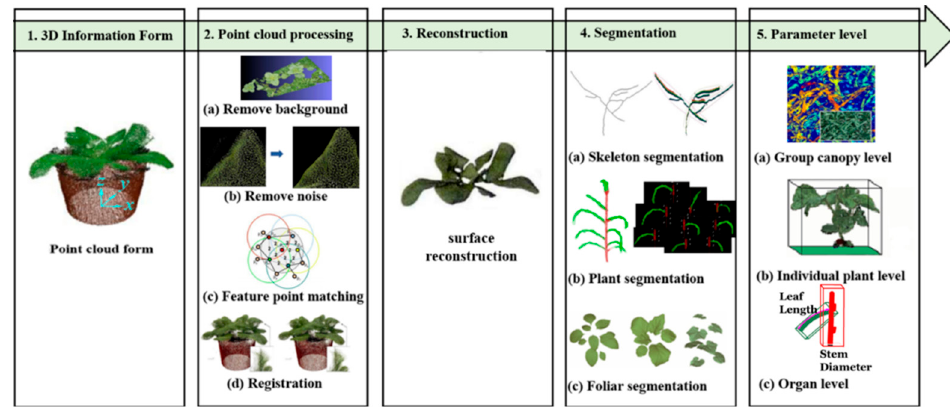
Figure 4. Flow chart of plant canopy structure measurement based on 3D reconstruction.